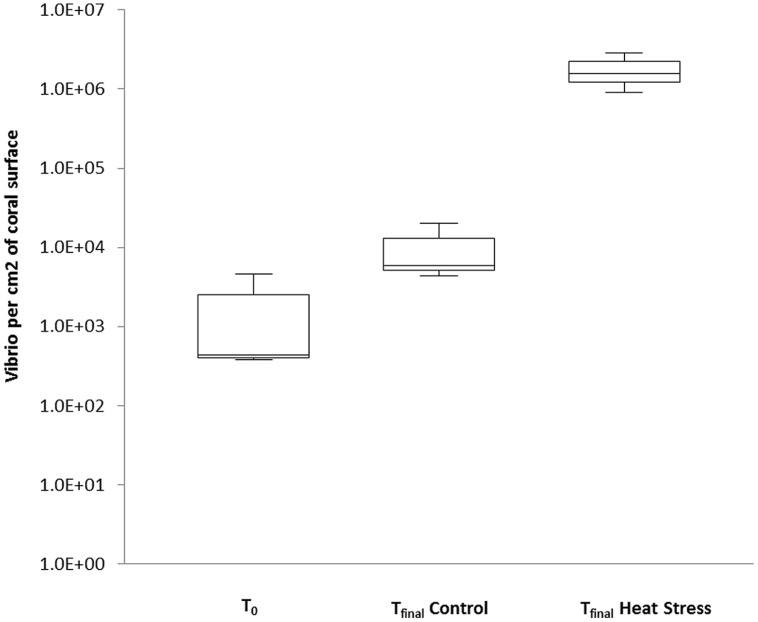
Quantitative PCR was performed to quantify the abundance of natural populations of Vibrios associated with the coral P. damicornis on Heron Island, the Great Barrier Reef at t0 (22°C), tfinal Control (22°C), and tfinal Heat stress (31°C) conditions. Standard curve: R2 = 0.99, Eff% = 93.1. Abundances are expressed as the number of bacteria per cm2. n = 3.